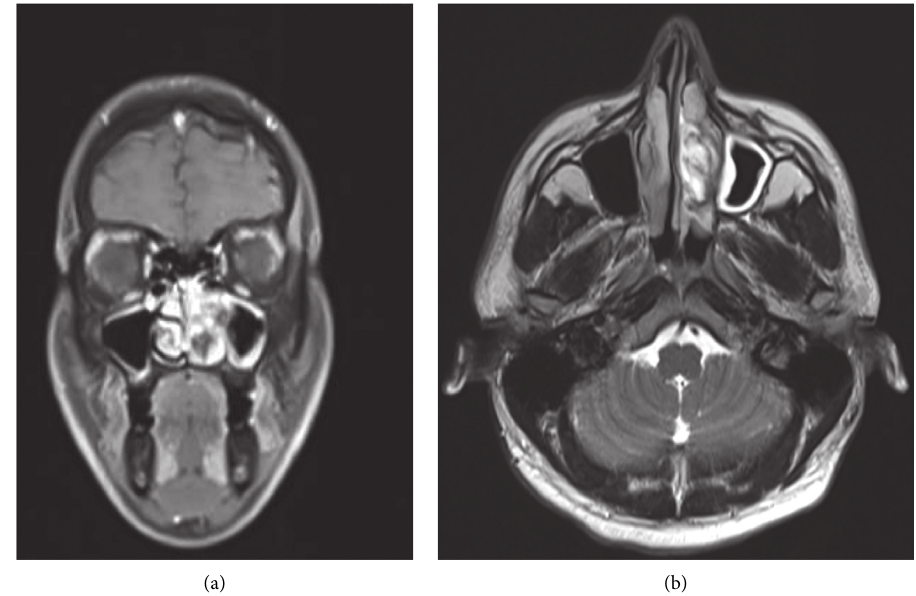
Figure 3: MRIscanoftheparanasalsinuseswith contrast.Thecoronal andaxialsectionshowsa leftanteriorheterogeneoushypointensenasalmass.